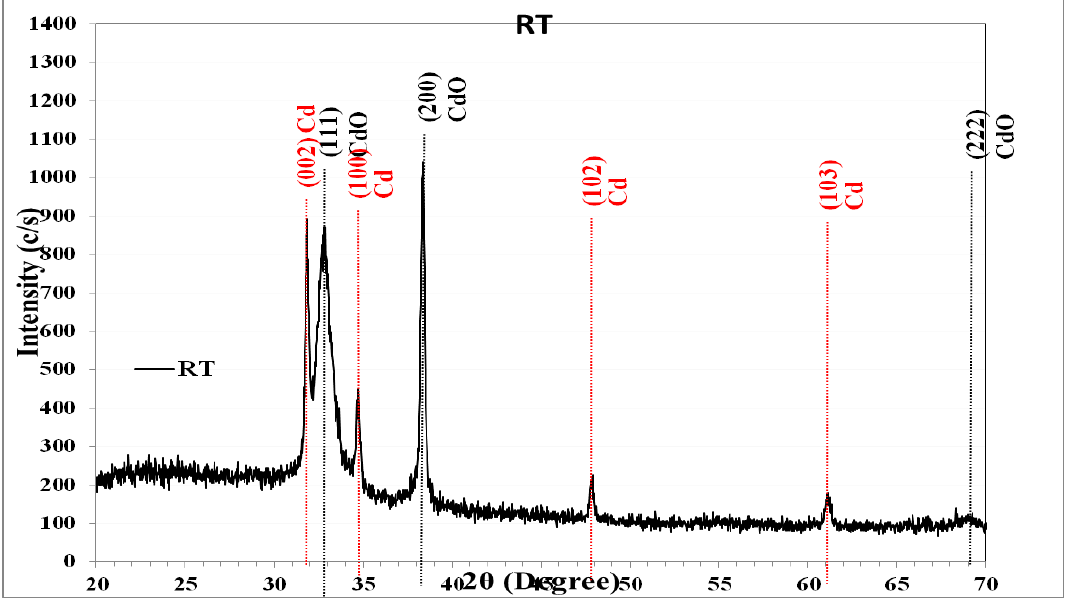
Fig. 1: X-ray diffraction curves CdO, Cd thin films deposited by voltage (1200) Volt at room